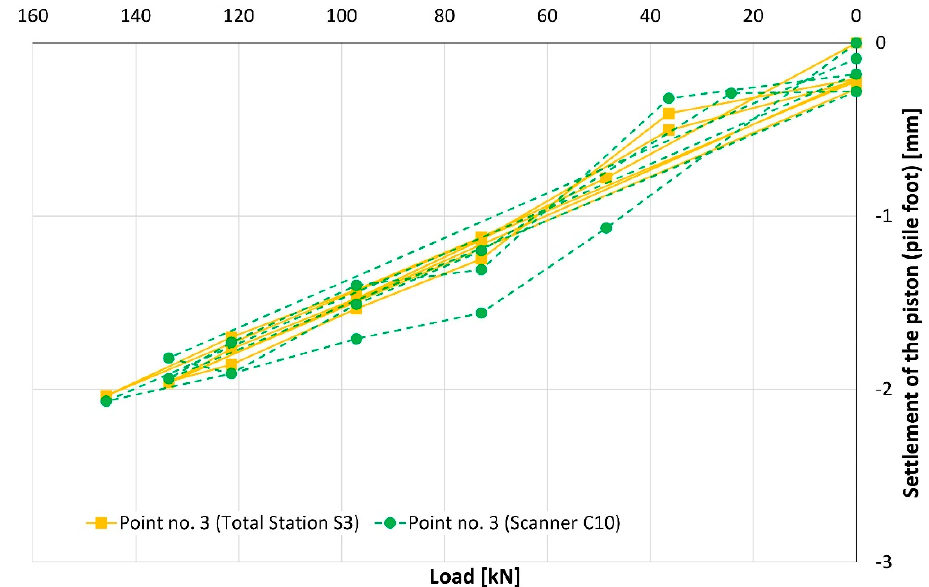
Figure 10. The settlement of the piston (pile foot) represented by point no. 3.